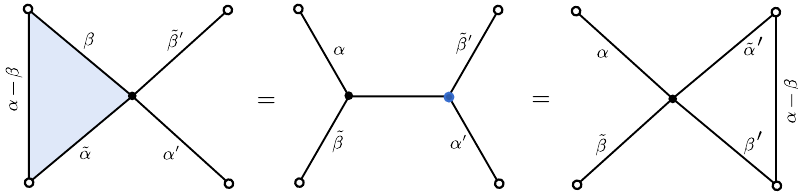
Figure 19 . Left: star-triangle identity in graphical form. We recall that ˜ x = d rule identity in graphical form.